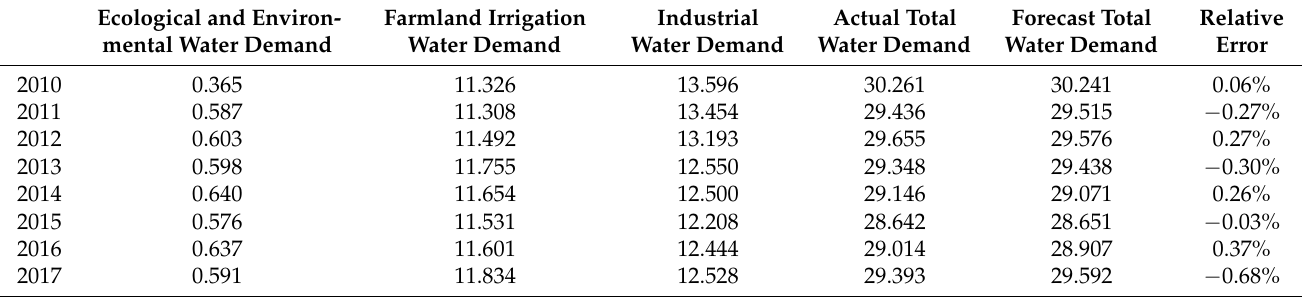
Table 1. Fitting result of actual value and predicted value of total water demand. Ecological and Environ- mental Water